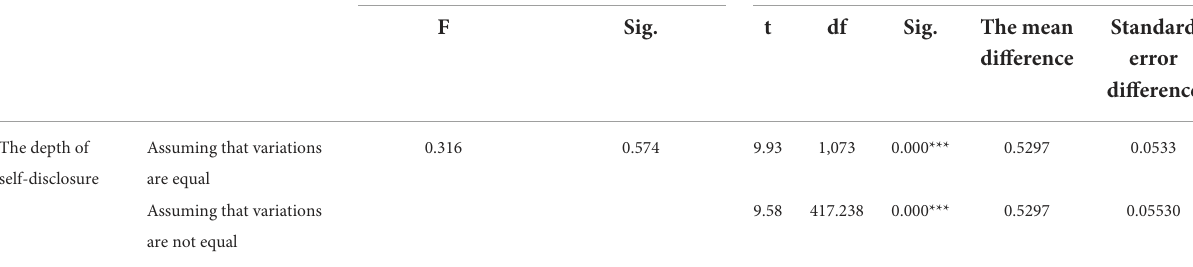
TABLE 8 T -test of independent